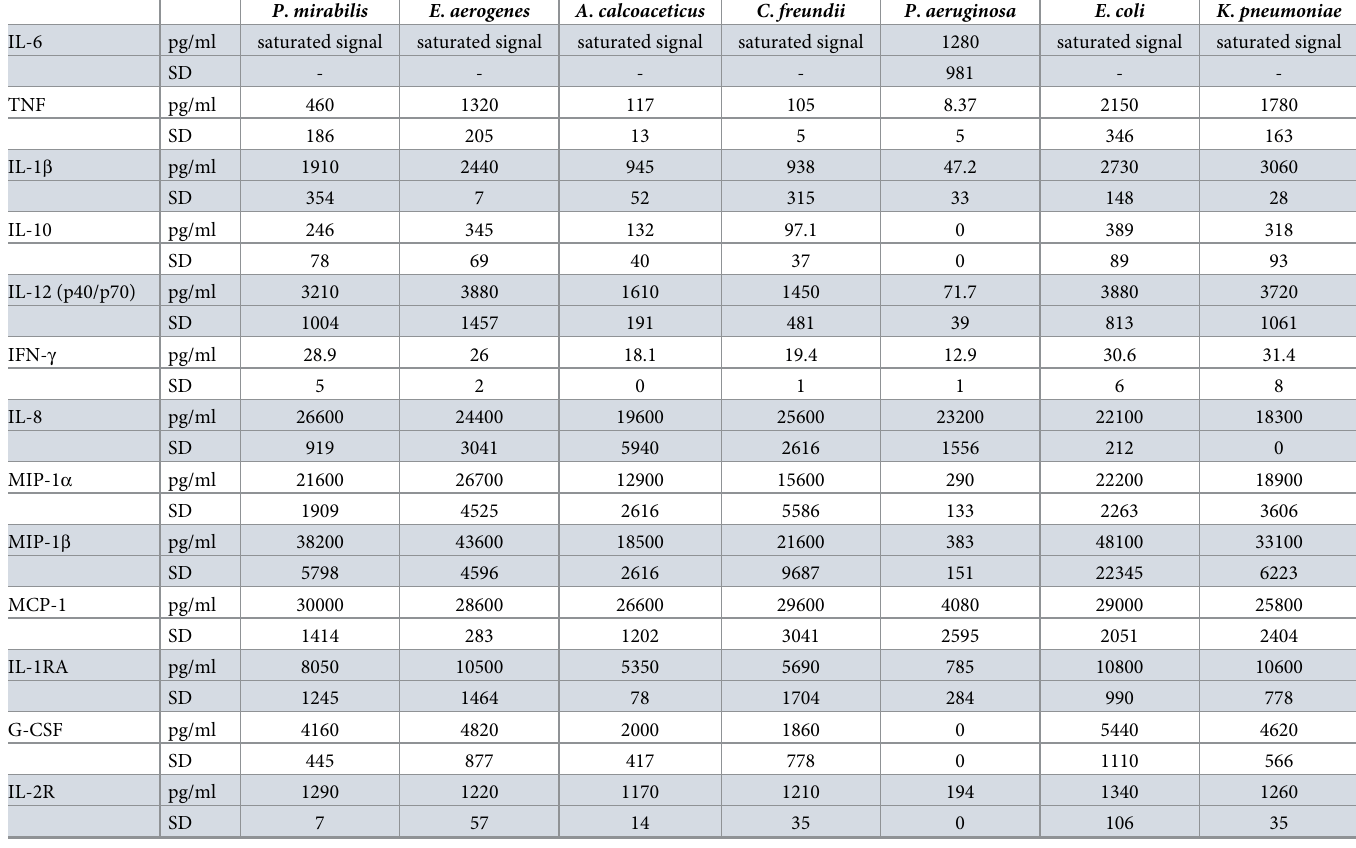
Table 2. Luminex assay using a human cytokine 30-plex panel on UBMC’s supernantant of Subject 1, following stimulation for 36 h with 37.5 ng/ml purified LPS obtained from the indicated baterial species ( E . coli , E . aerogenes , K . pneumoniae , P . mirabilis , A . calcoaceticus , C . freundii , P . aeruginosa ). Abbreviation: SD, stan- dard